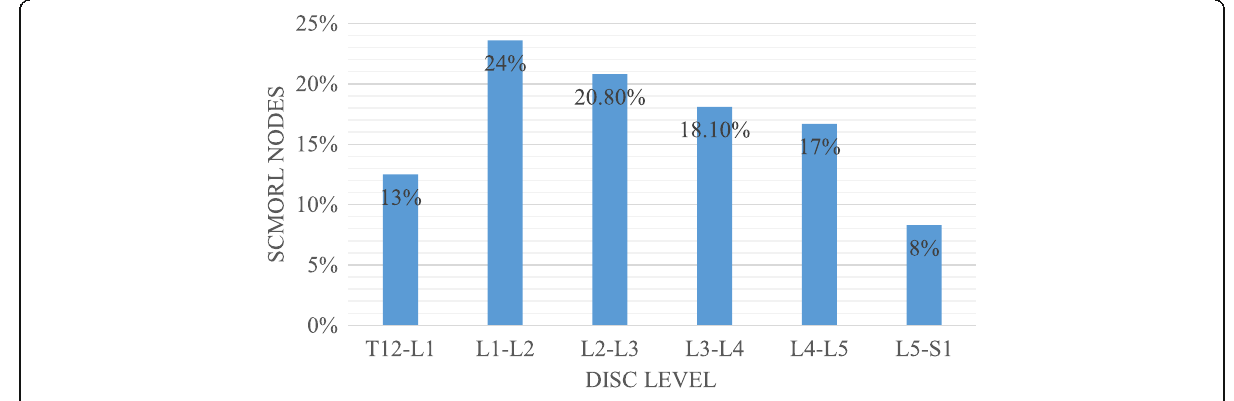
Fig. 2 Bar chart showing the overall prevalence of Schmorl ’ s nodes (SN) by vertebral